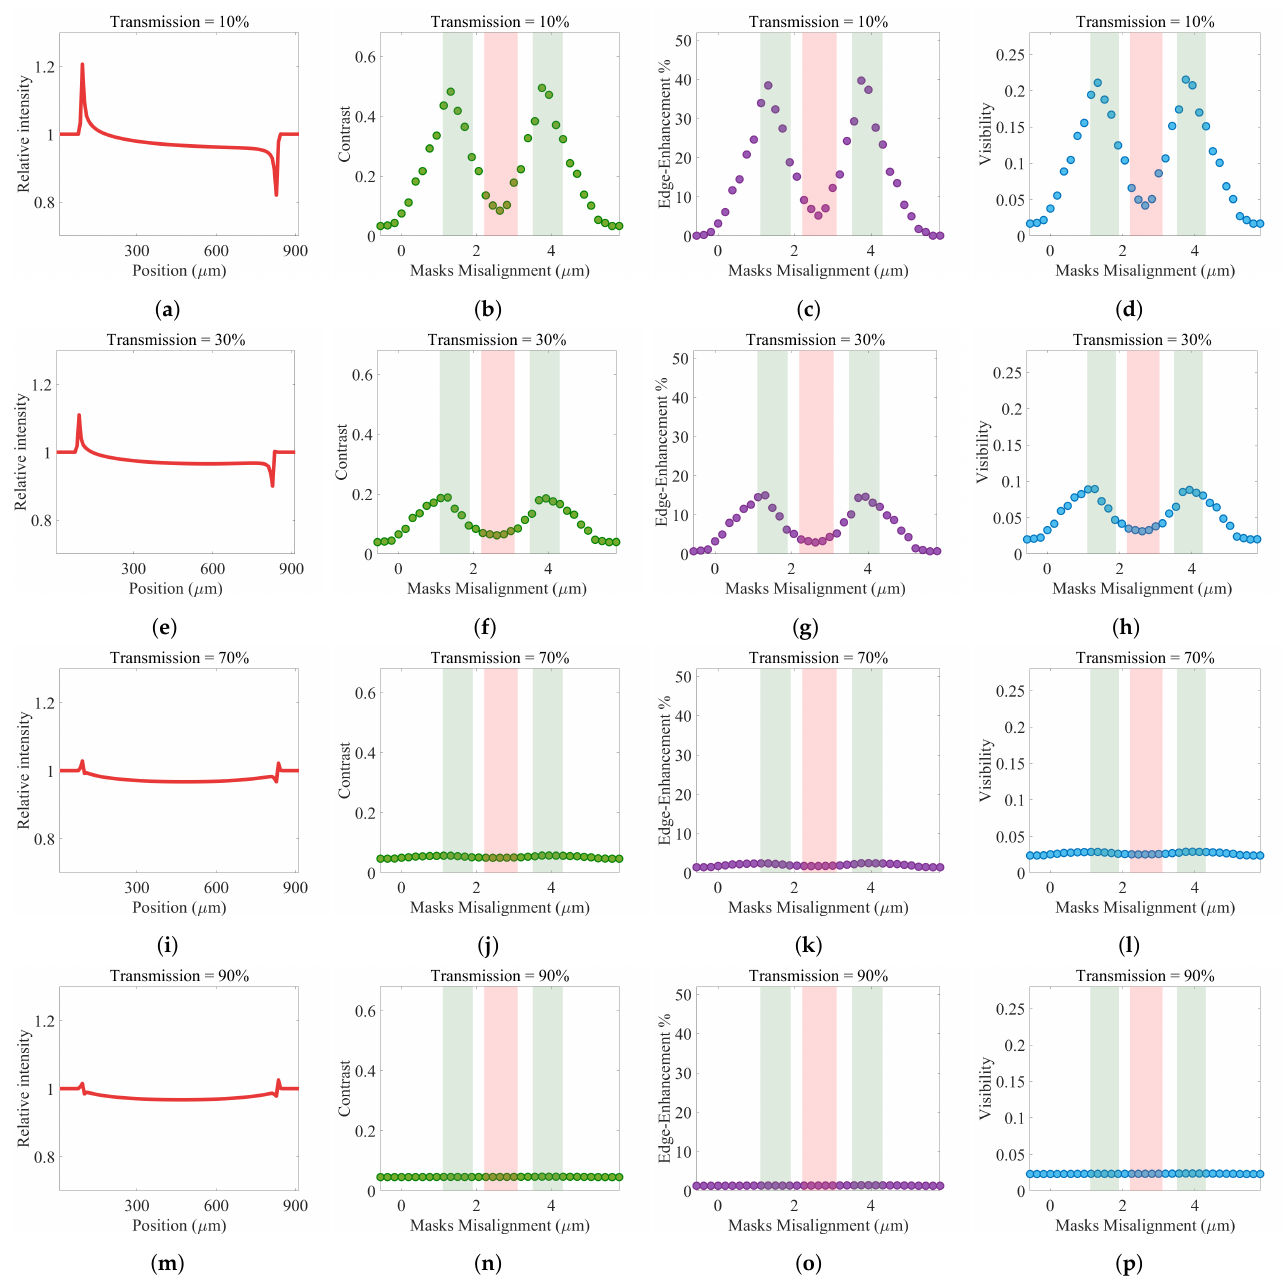
Figure 10. The effect of detector mask thickness variation on the performance of a high-resolution EI-XPCi system. As beamlets’ transmission through the absorption mask increases, the system shifts from EI to PB